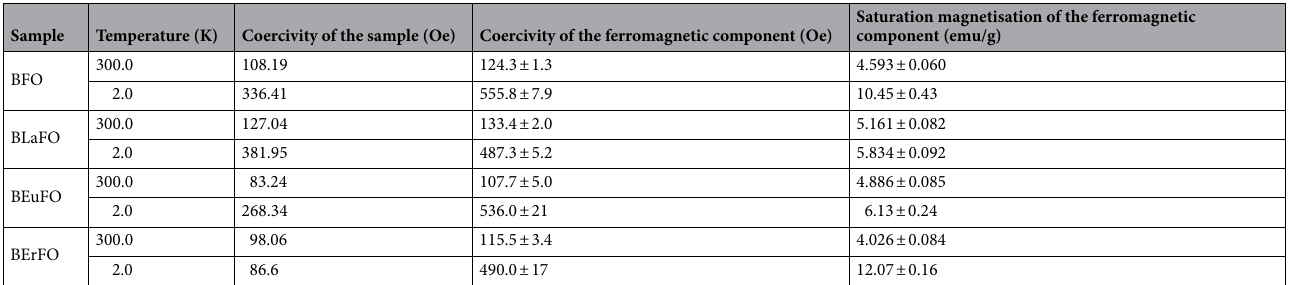
Table 4. Coercive field and the saturation magnetisation based on the fits.